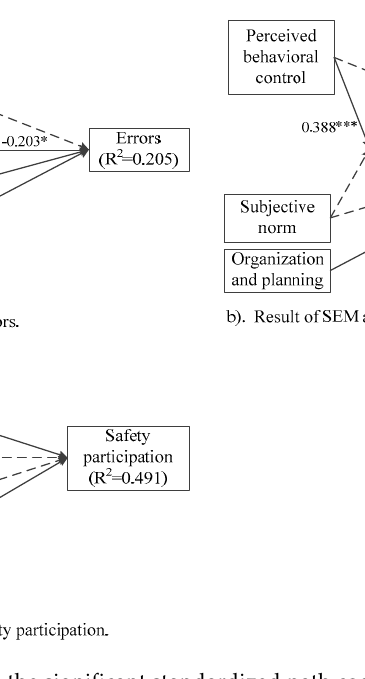
Figure 2. The final model and the significant standardized path coefficients, ( a ) result of SEM analysis for errors, ( b ) result of SEM analysis for violations, ( c ) result of SEM analysis for safety participation. * p < 0.05; ** p < 0.01; *** p < 0.001; dotted line represents a nonsignificant path parameter.